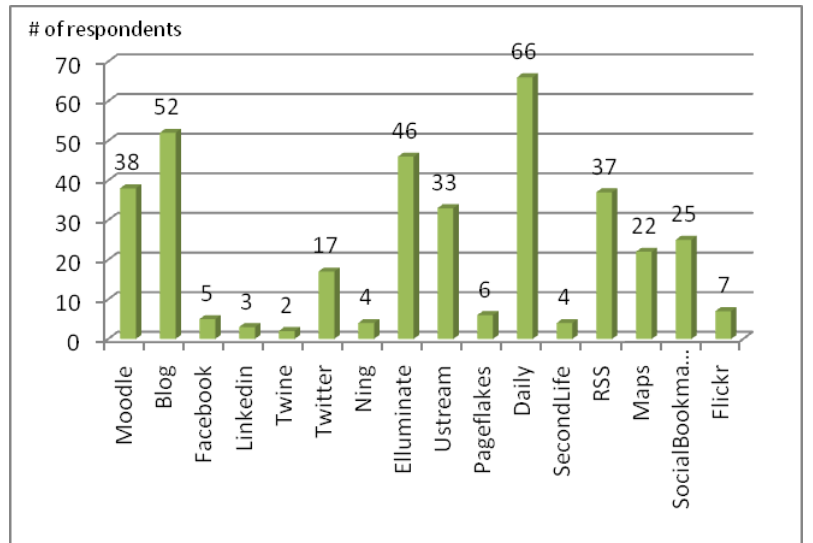
Figure 11 . Frequency of high relevance ( N =